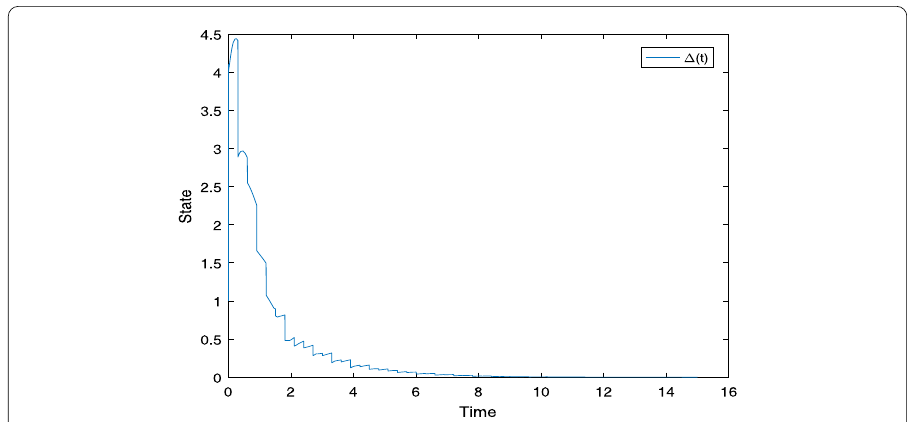
Figure 9 Variation of (cid:15) ( t ) in Example 4.1 of (4.1) with control